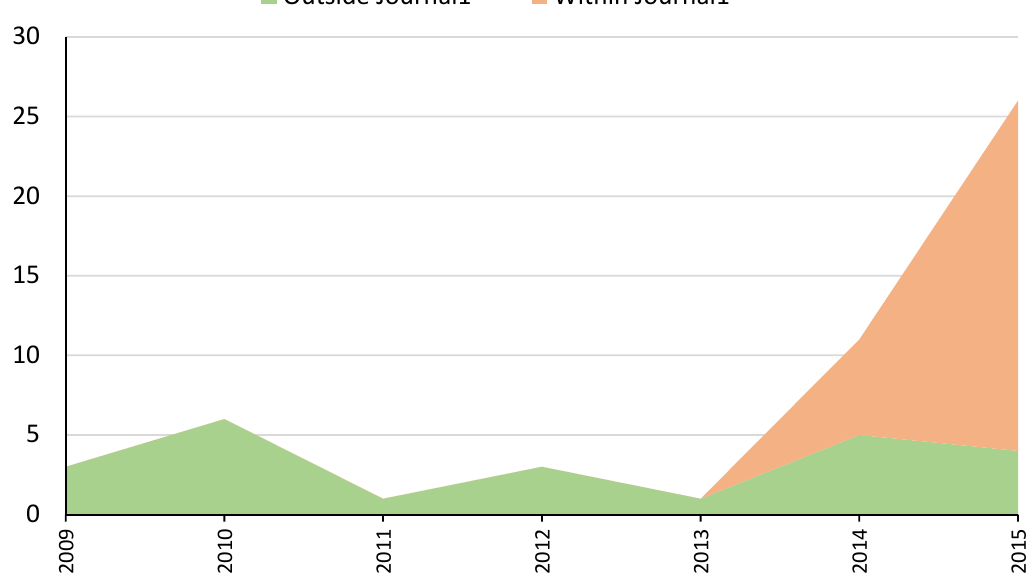
Figure 4. Citations of Author3’s papers in WoS distinguishing between citations of Author3’s papers, wherever published, whether cited or not in Journal1.